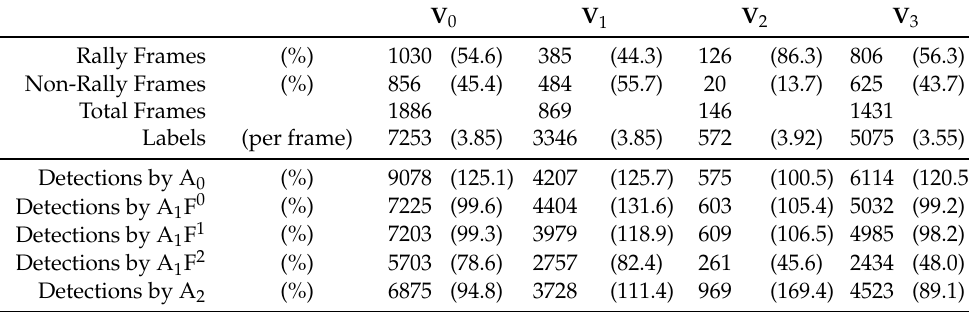
Table 5. Dataset label and detection statistics. Top: Dataset statistics with respect to game state. Bottom: Detections per HPE-CNN for all